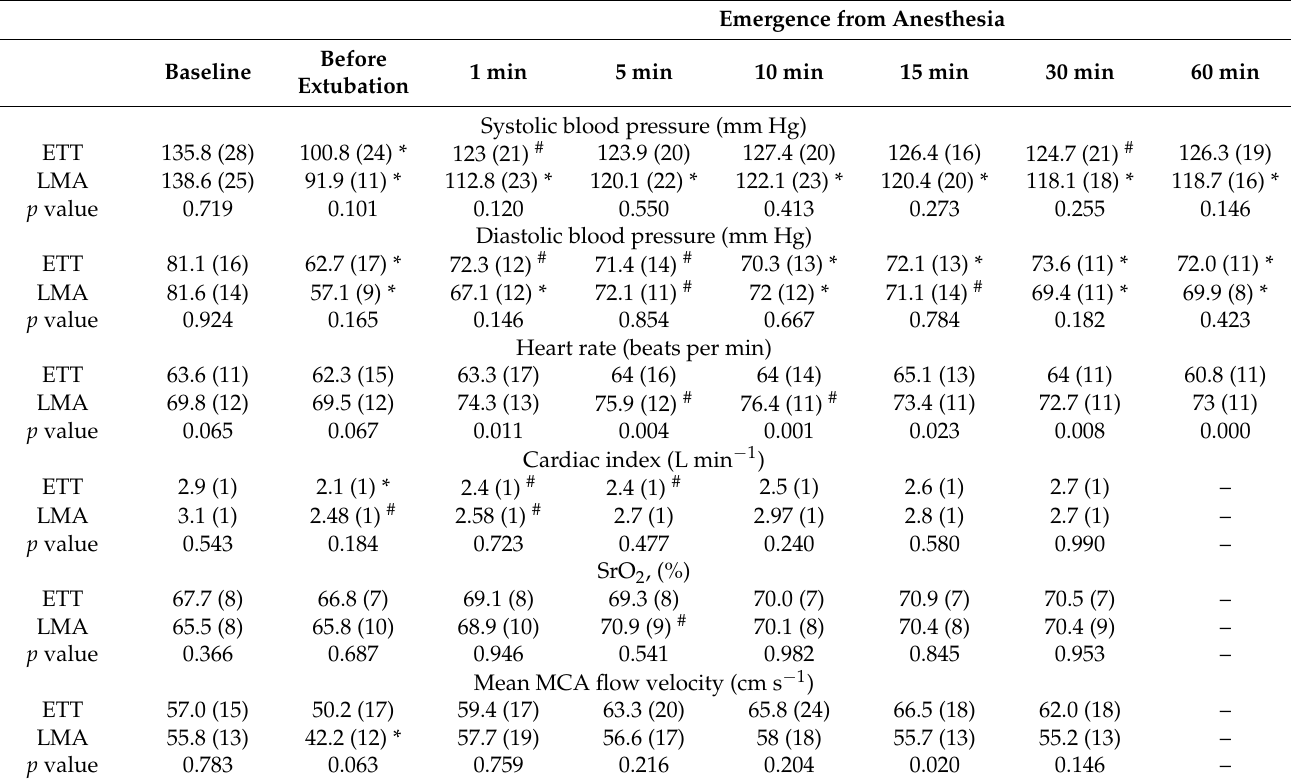
Table 2. Hemodynamic data of patients in both groups.